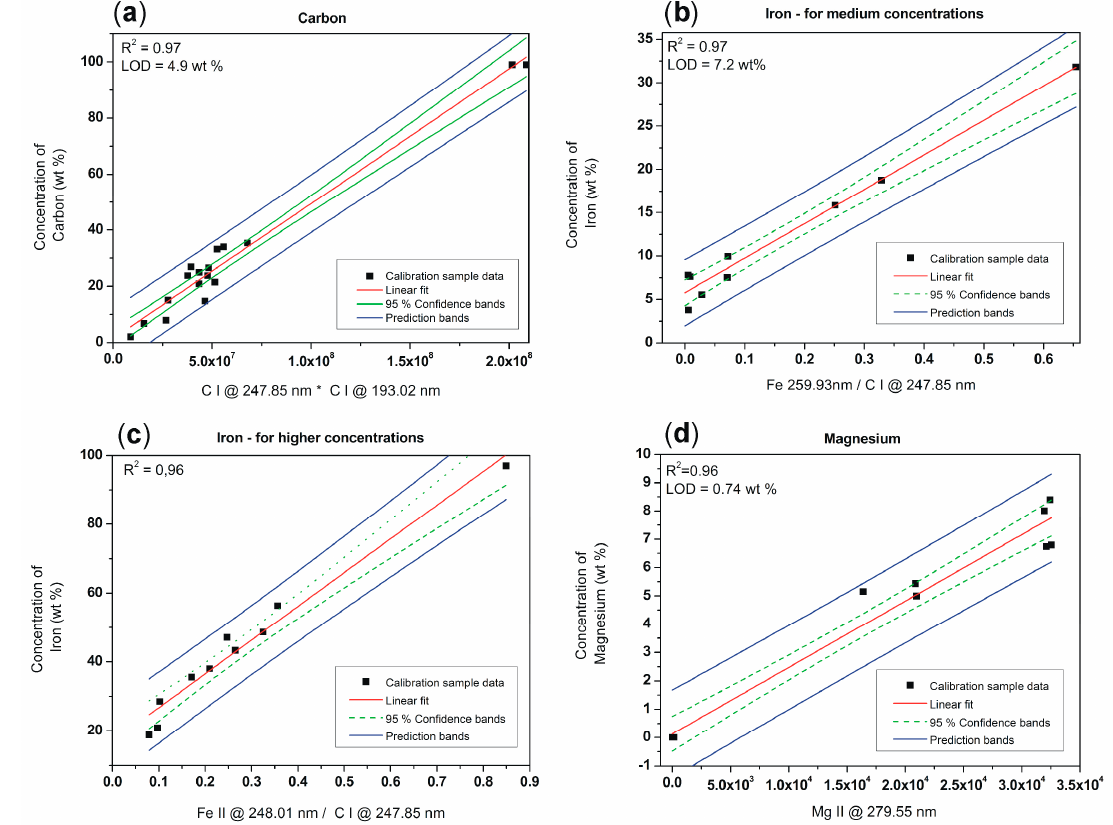
Figure 4. Calibration curves including regression parameter R 2 , limit of detection (LOD), 95% confidence limits and prediction bands for: ( a ) carbon, ( b ) iron—medium concentrations, ( c ) iron—high concentrations and ( d ) magnesium obtained from laboratory prepared PM calibration